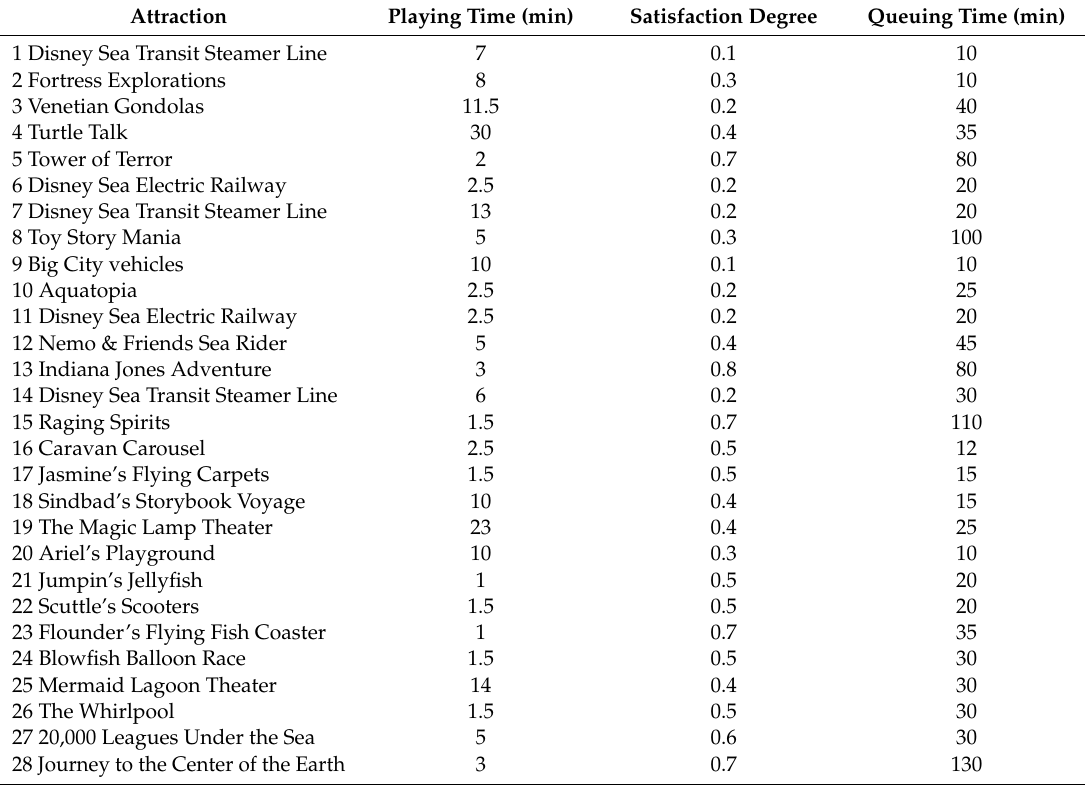
Table 2. Playing time, queuing time, and satisfaction degree for each attraction in Tokyo Disney Sea.